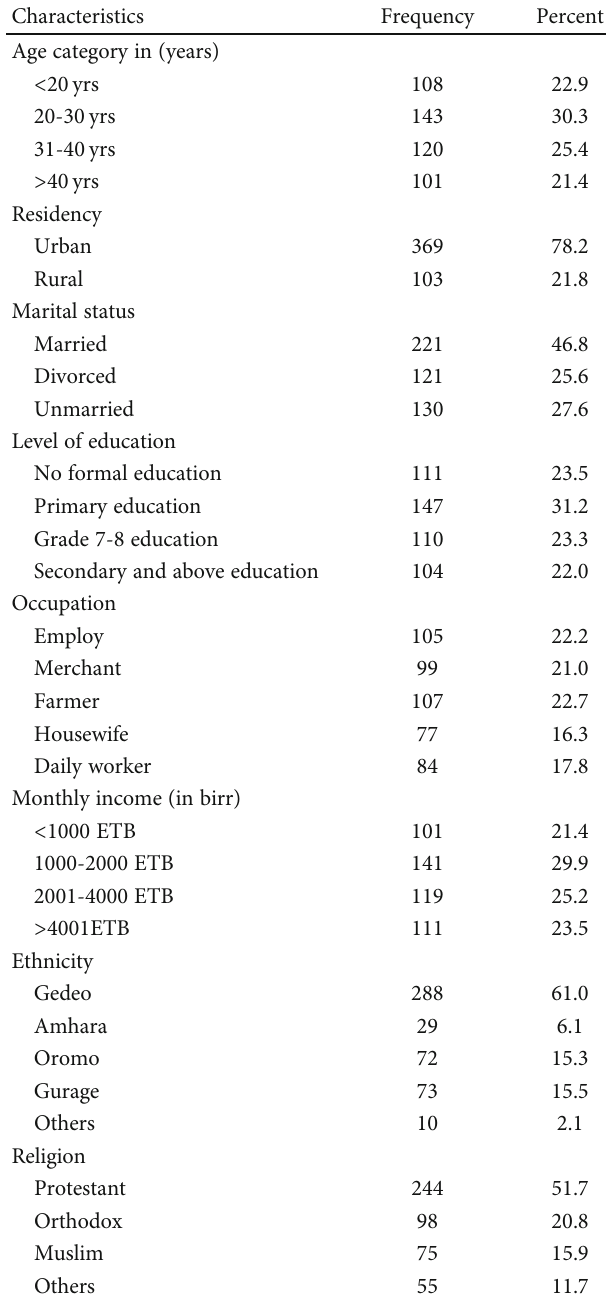
Table 1: Sociodemographic characteristics of the